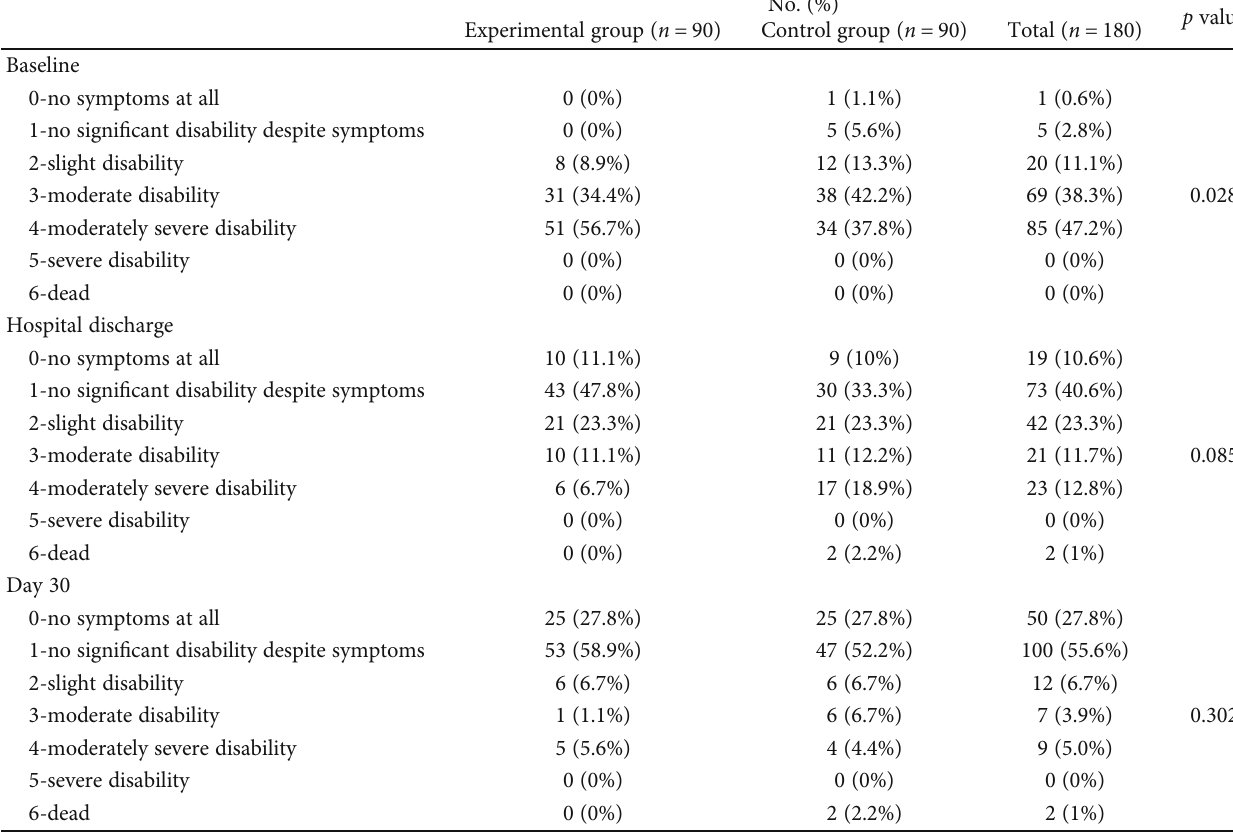
Table 4: The mRS score distribution.